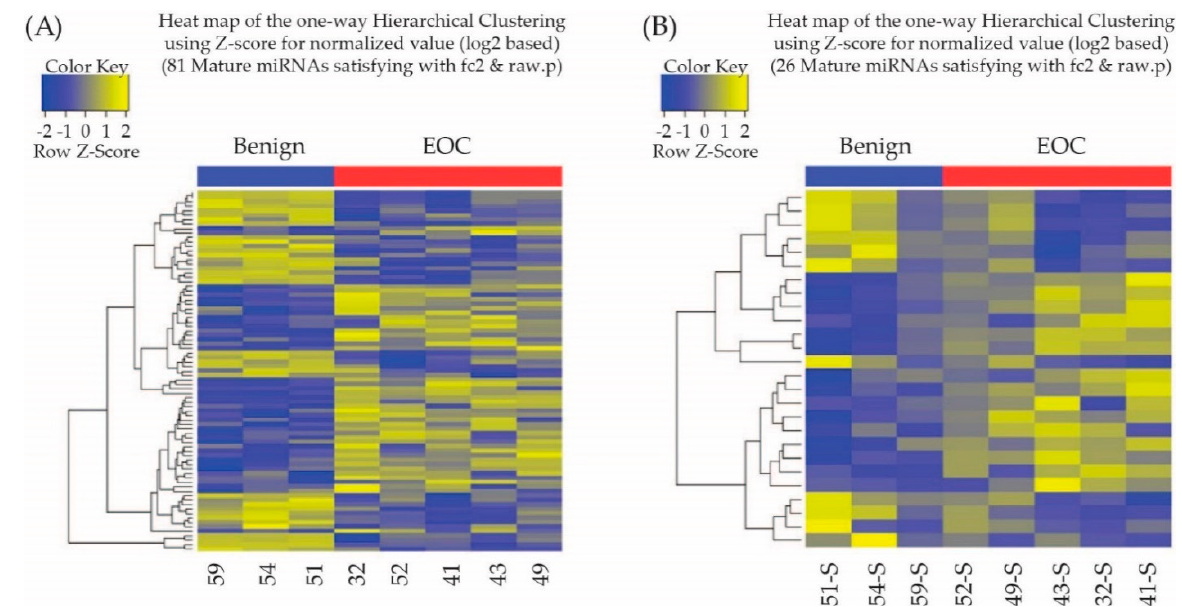
Figure 1. ( A ) Heatmap showing z score of miRNAs from benign tumors ( n = 3) and malignant tumors ( n = 5) with 44 upregulated (yellow) and 37 downregulated (blue) miRNAs. ( B ) Heat map showing z score of exosomal miRNAs from serum of benign tumors ( n = 3) and malignant tumors ( n = 5) with 15 upregulated (yellow) and 11 downregulated (blue) miRNAs. Results are also shown in a volcano plot from serum and tissue samples (Figure 2). Only seven miRNAs (hsa-miR-1246, hsa-miR-1290, has miR-21-5p, hsa-miR-7-5p, hsa- miR-93-5p, hsa-miR-16-5p and hsa-miR-29c-3p) were identified as differentially expressed in both matched tissue and serum samples (Table 3).